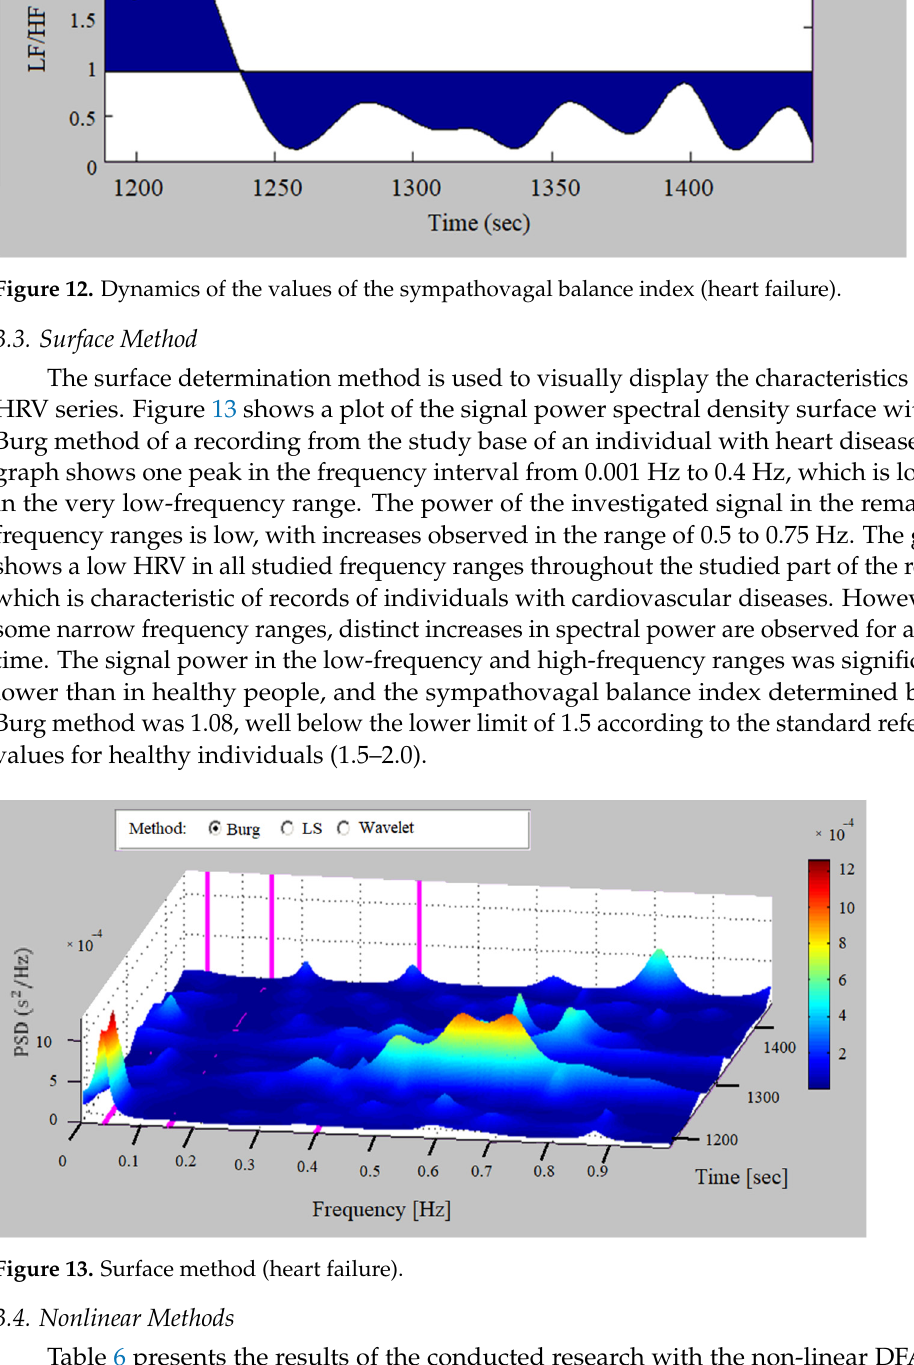
Table 6. Parameters of the nonlinear analysis of the studied records.